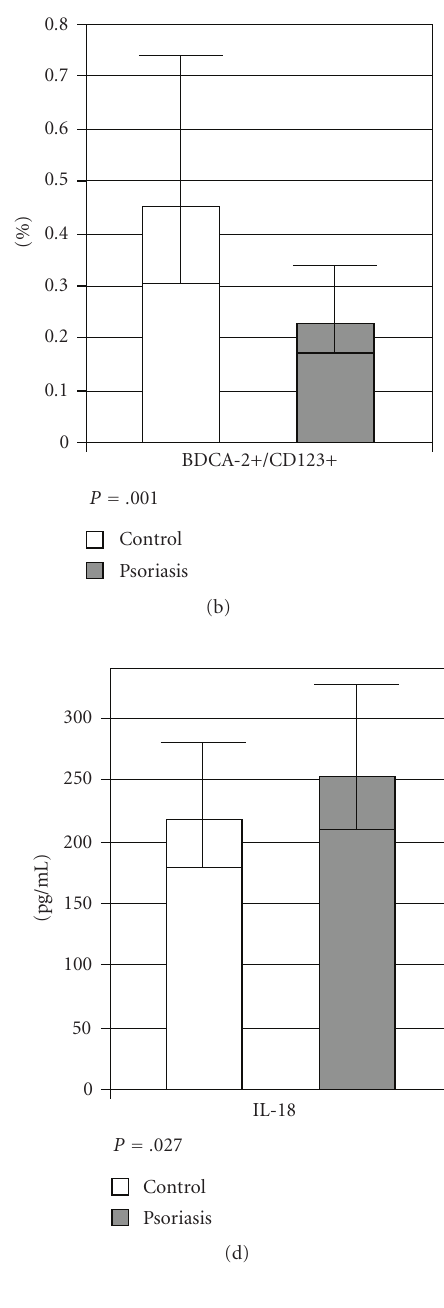
Figure 2: Comparison between men with psoriasis and healthy subjects: (a) percentages myeloid BDCA-1+/CD19- DCs, (b) plasmacytoid BDCA2+/CD123+ DCs, (c) myeloid/plasmacytoid ratio, and (d) blood concentration of IL-18. Results are shown as median values and 25–75